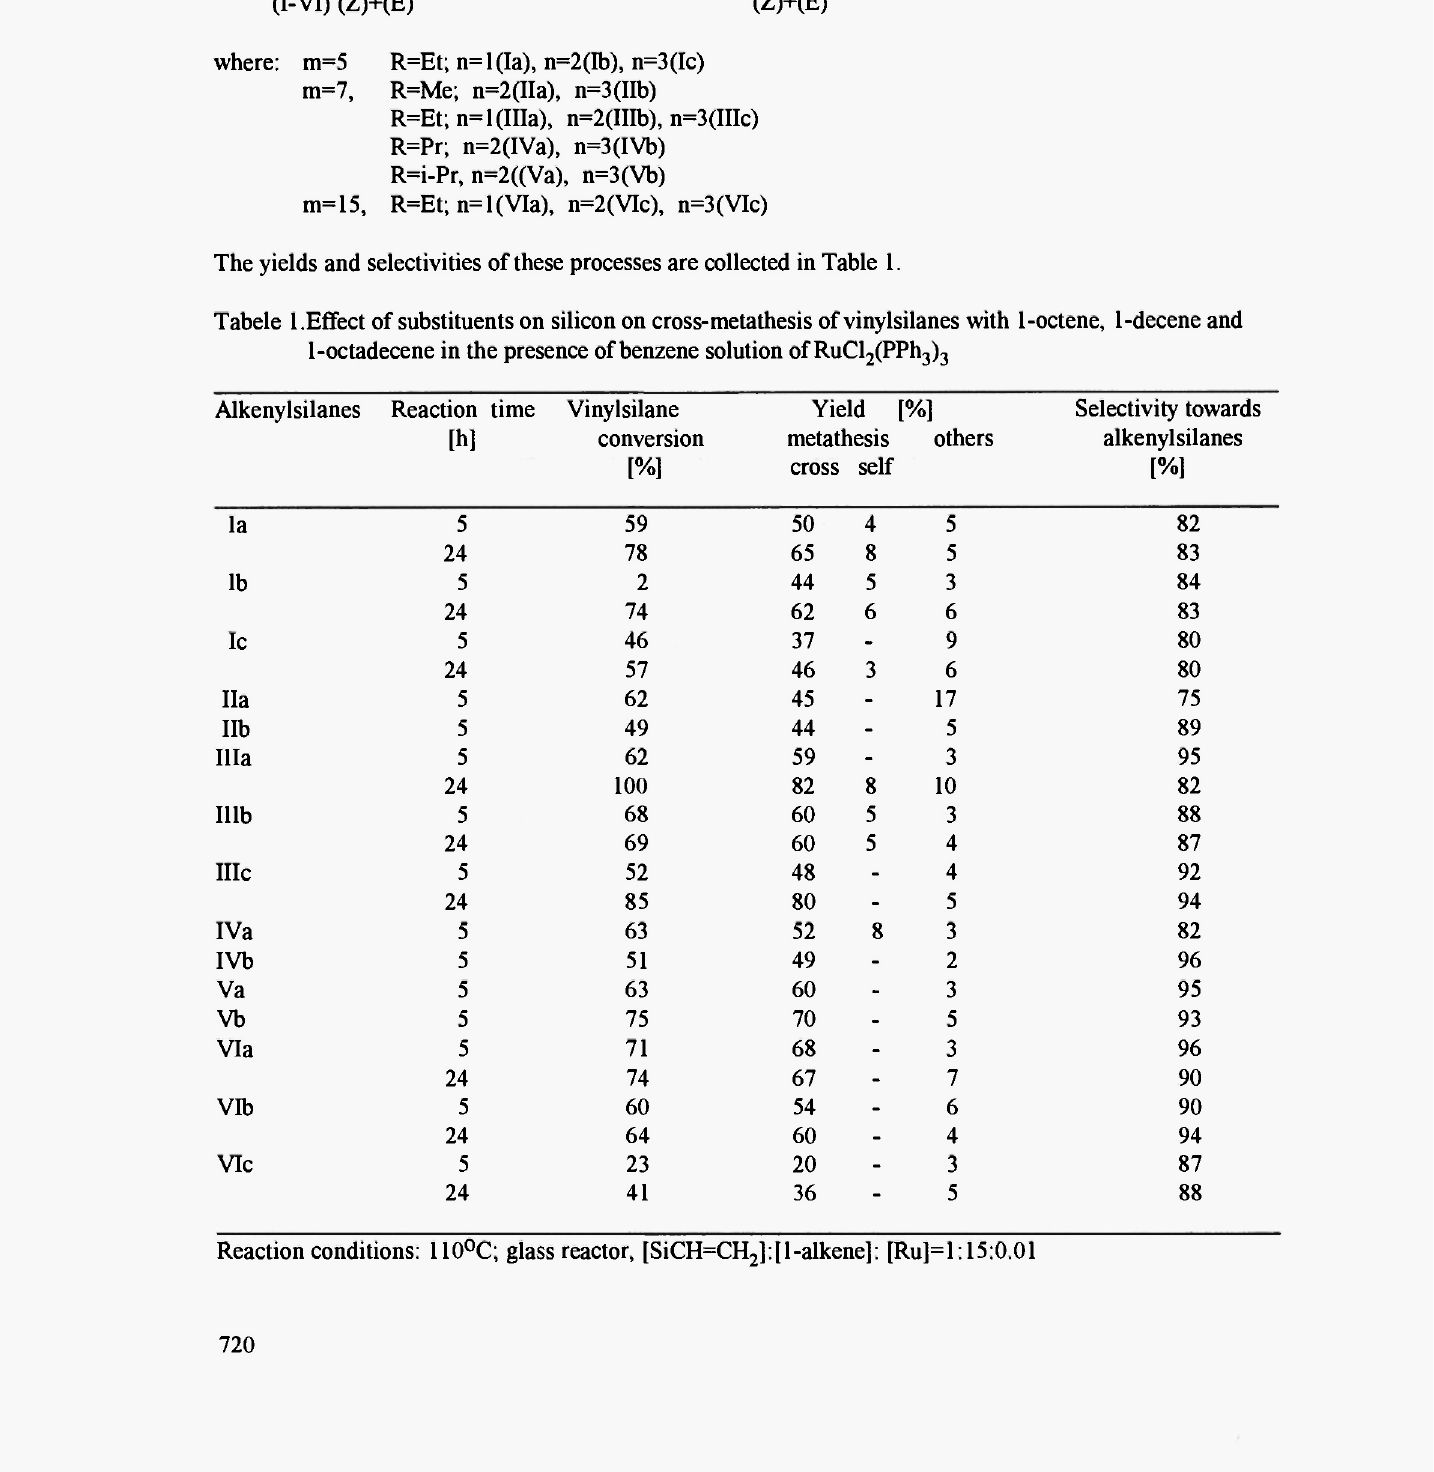
Tabele 1.Effect of substituents on silicon on cross-metathesis of vinylsilanes with 1-octene, 1-decene